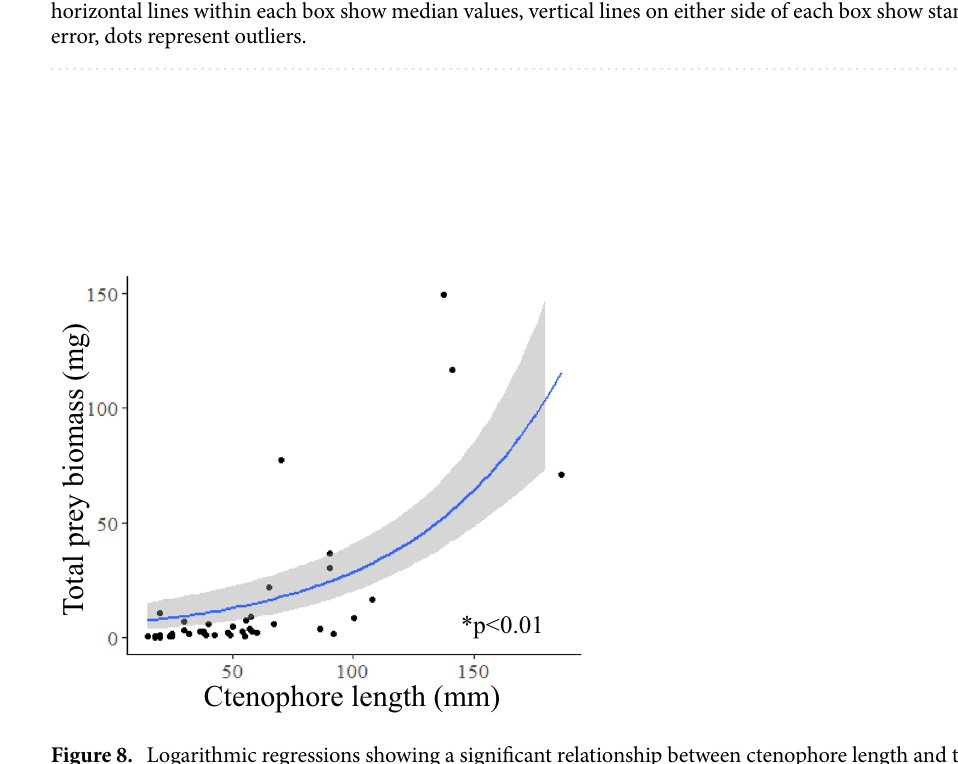
Figure 8. Logarithmic regressions showing a significant relationship between ctenophore length and total prey biomass in the gut ( p < 0.01, r 2 = 0.57). Grey shaded region shows 95% confidence interval. Two outliers were removed from the plot for visualization purposes